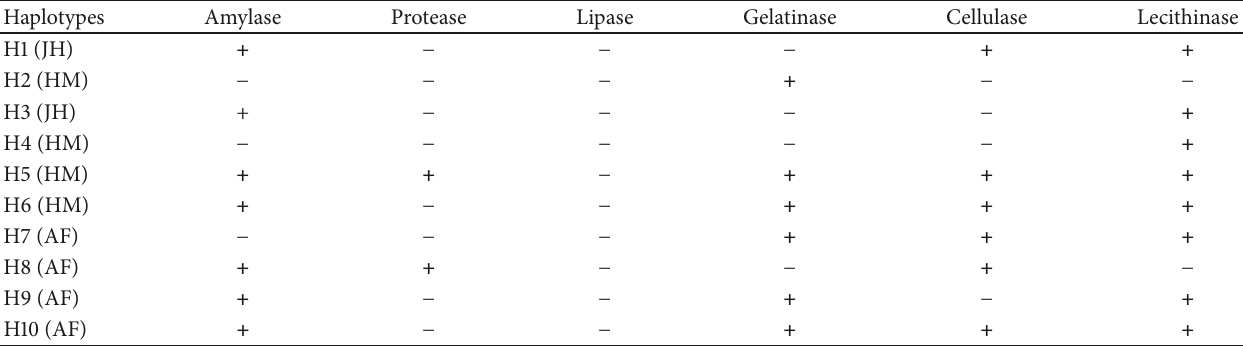
Table 4: Variation in enzymatic activity produced by Thermomonas hydrothermalis (H1) and Bacillus licheniformis (H2–H10) strains. JH, Jordan Hemma; HM, Hammamat Mae’en; AF, Afra.